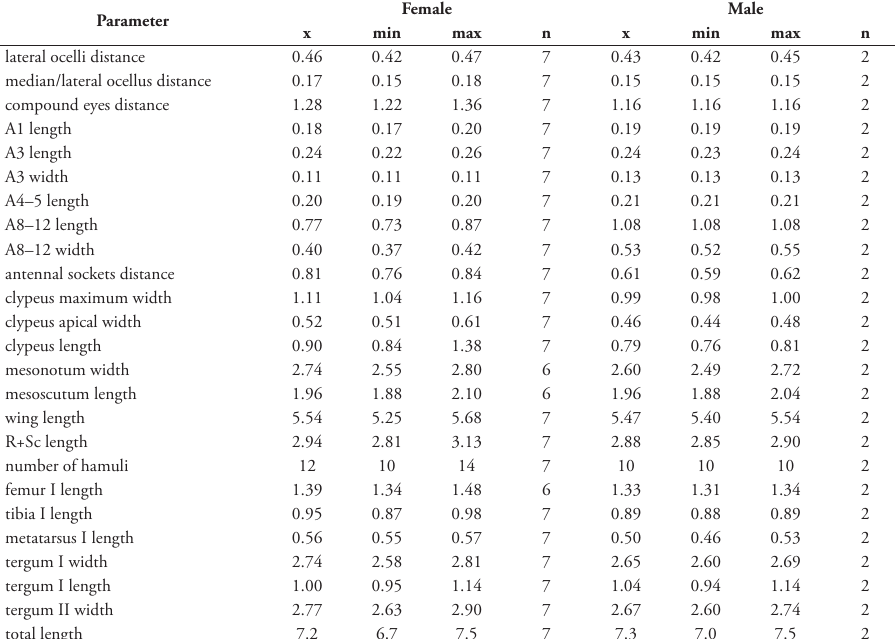
Table 1. Measurements of the exoskeleton of imagines of Celonites hermon (x = median; min = minimum, max = maximum; measurements were made with a Wild M3 stereomicroscope with maximum magnifica- tion 80×, maximum accuracy 0.011 mm, all distances in mm). Female Male Parameter x min max x min n lateral ocelli